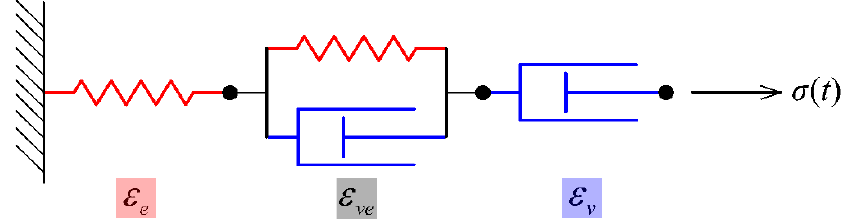
Figure 9. Modified Burgers model.